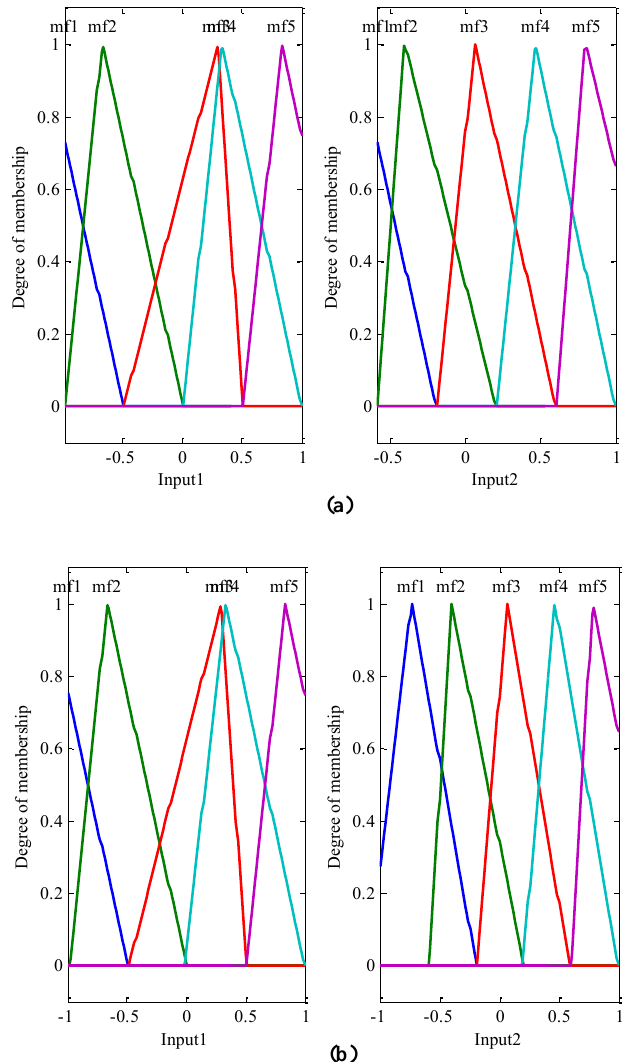
Fig. 5. Triangular membership functions for ANFIS-ICA model, (a) initial, (b)